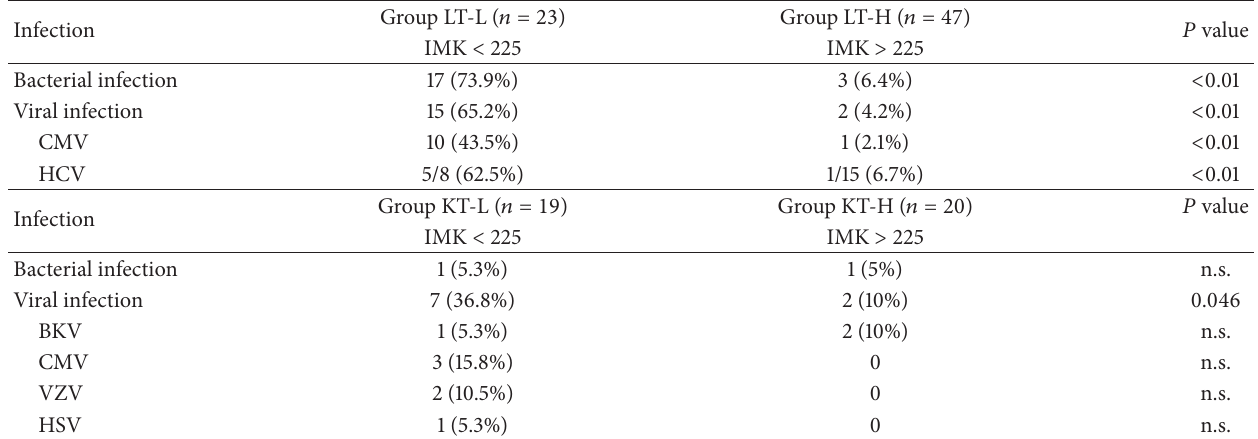
Table 3: Occurrence of infection in LT and KT patients according to IMK ATP